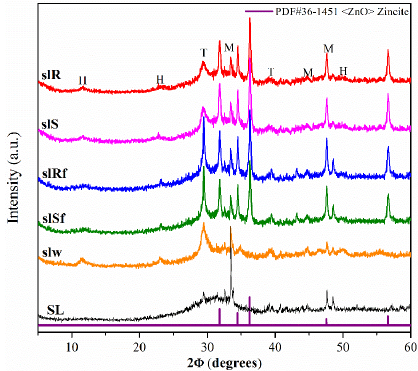
Figure 2. XRD diffractograms of metallurgical slag-based pastes with nanoparticles functionalized and without functionalization.